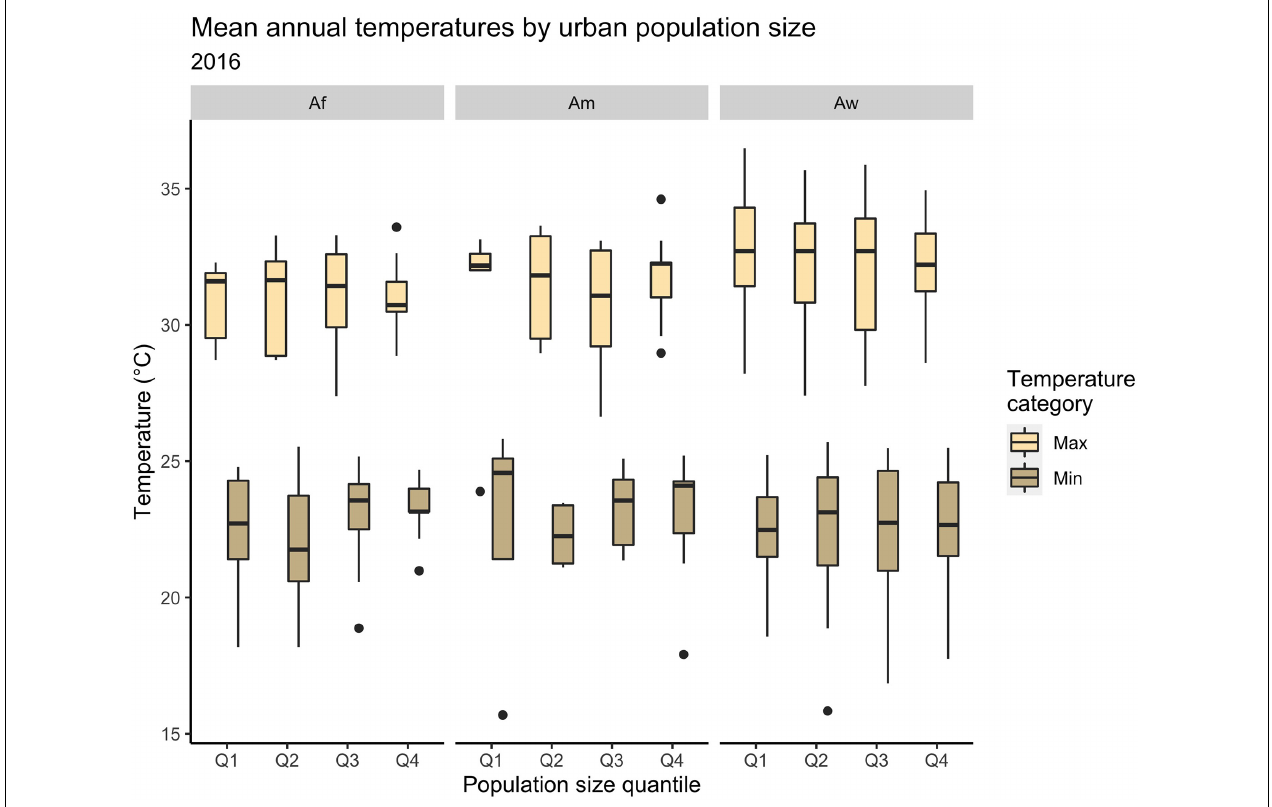
FIGURE 11 | Mean annual temperatures across urban population size gradients. Data source: NOAA, GHCN and UN,